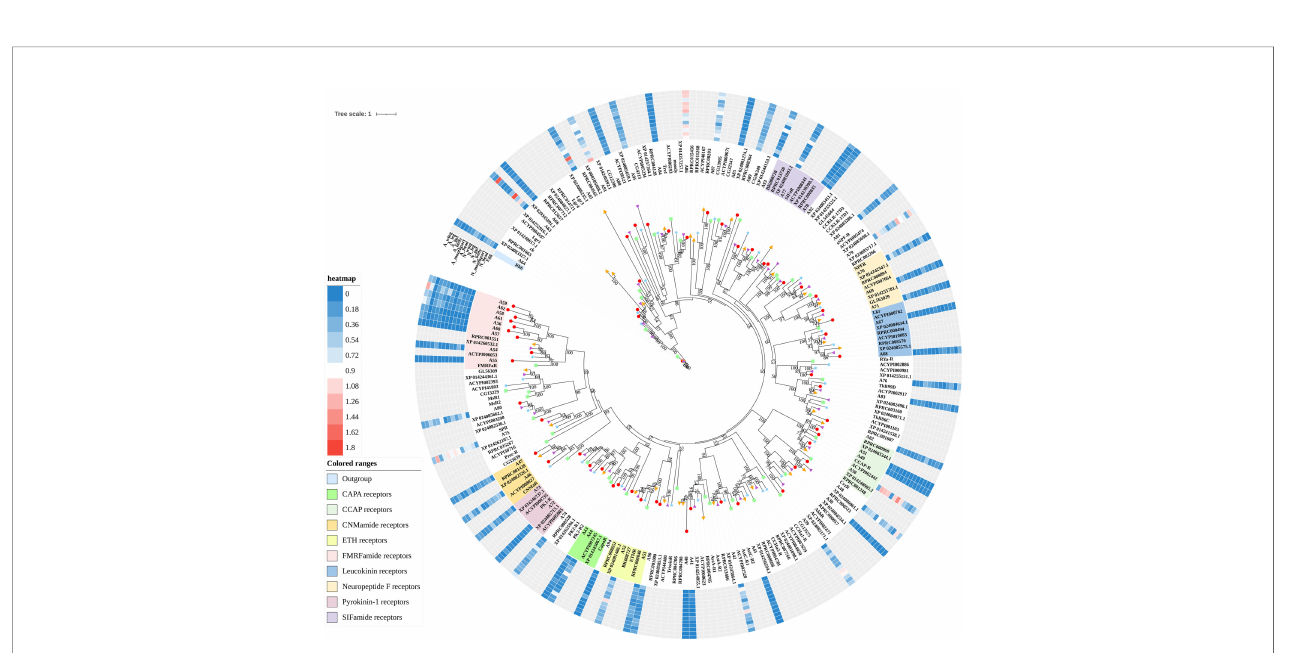
FIGURE 2 | Phylogenetic tree reconstruction of neuropeptide and protein hormone receptors from D. melanogaster (green square), A. pisum (blue star), R. prolixus (orange right triangle), C. lectularius (purple left triangle), and A. lucorum (red circle) inferred from maximum likelihood (ML) analysis. Numbers at nodes on the tree were the bootstrap values (below 50 are not shown). The tree was rooted by the D. melanogaster opsin GPCR Rh6. Expression pro fi les of A. lucorum GPCR genes from different tissues are shown in the corresponding branch side. The transcription level of each gene is represented by a square with a color that codes for the values of Lg (TPM+1). N, nymph; A,